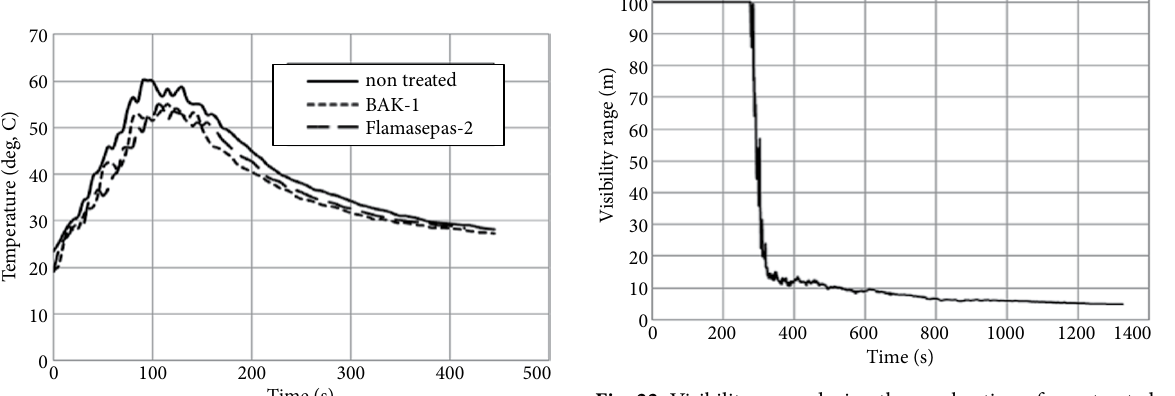
Fig. 22. Visibility range during the combustion of non-treated pine timbers measured by the sensor located at a height of 1.6 m (for treated pine timbers, visibility was equal to zero during the